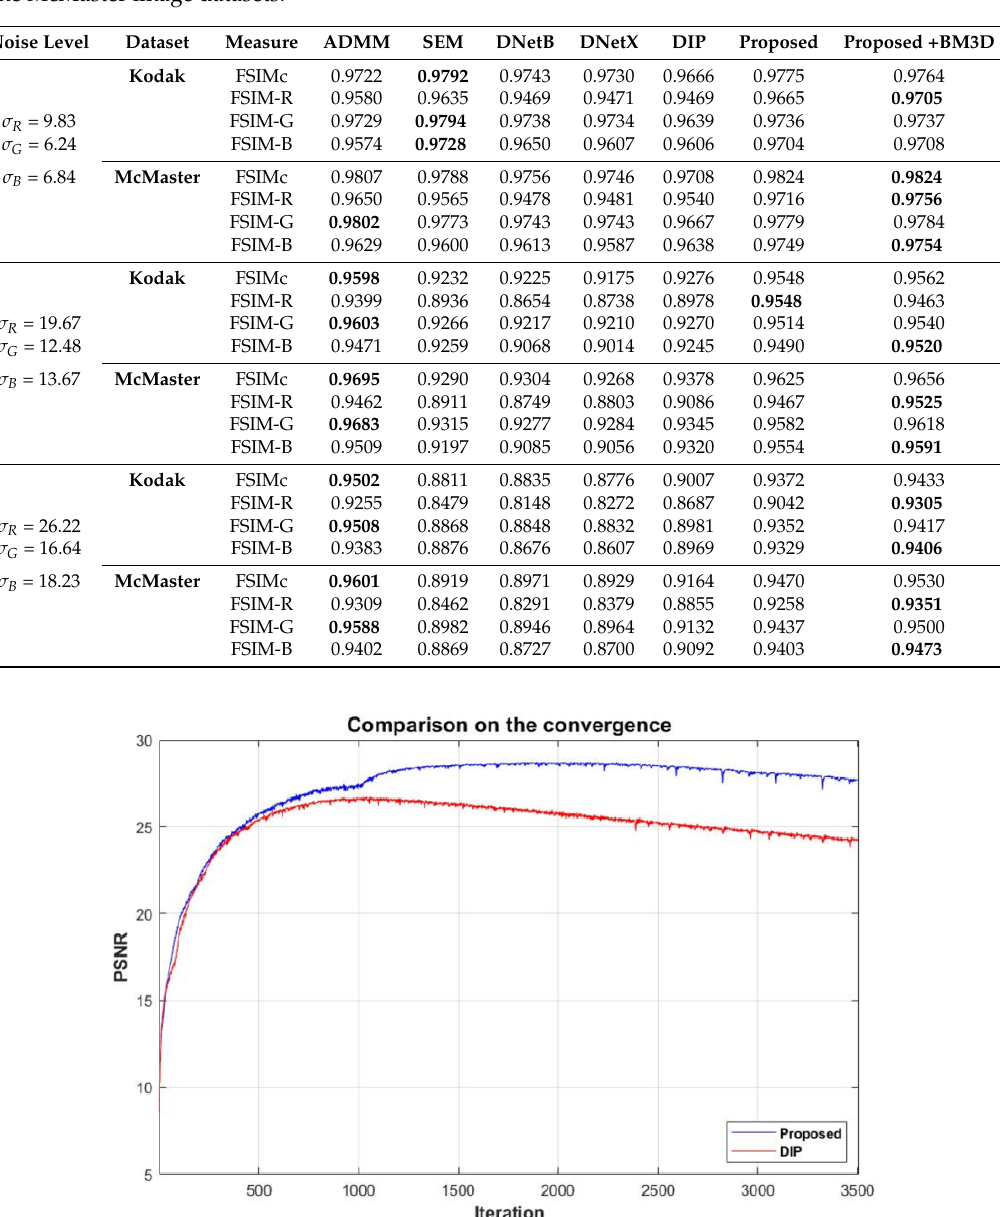
Table 4. Comparison of the FSIM values among the various demosaicing methods on the Kodak and the McMaster image datasets.